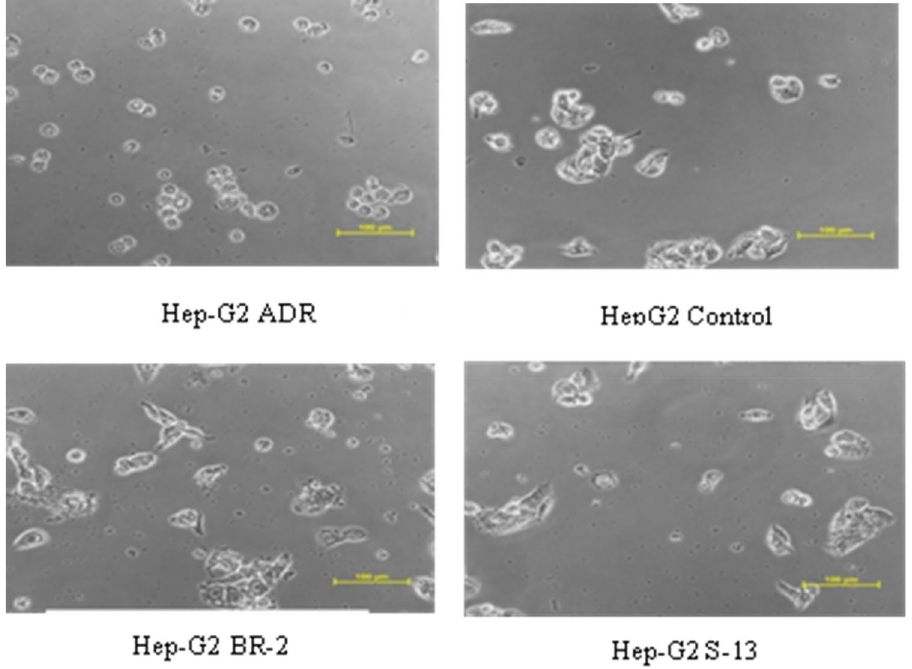
Figure 5. Images of cancer cell line Hep-G2 treated with mulberry pectin BR-2, S-13 and standard drug (Adriamycin).